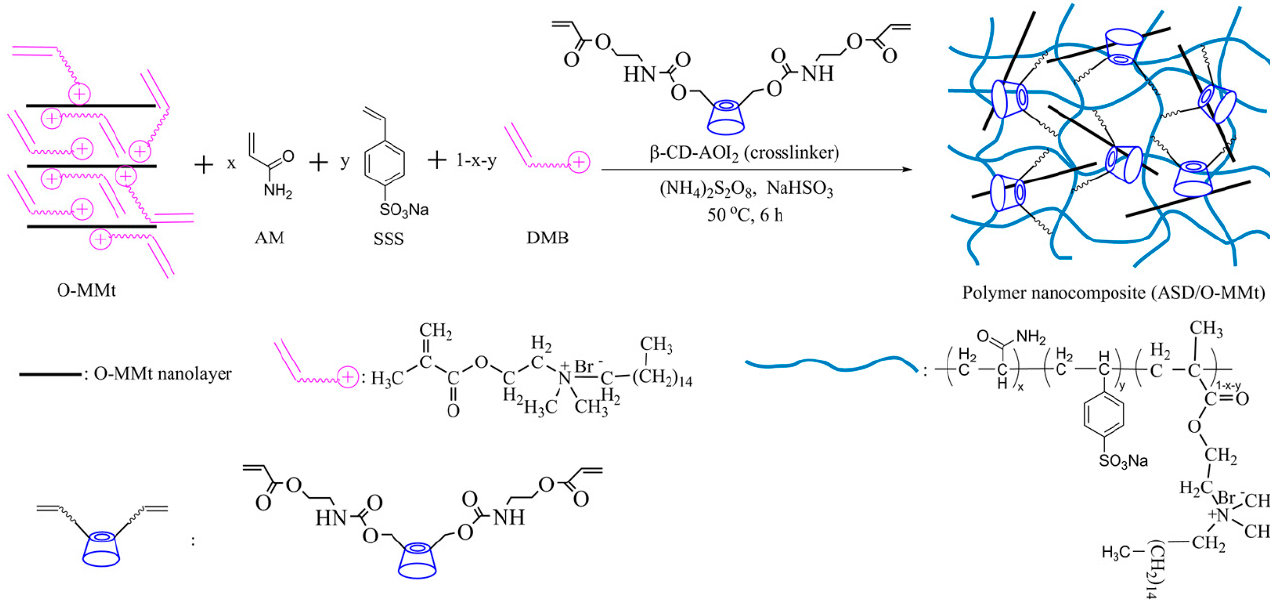
Figure 3. Synthesis of ASD/O-MMt nanocomposites.